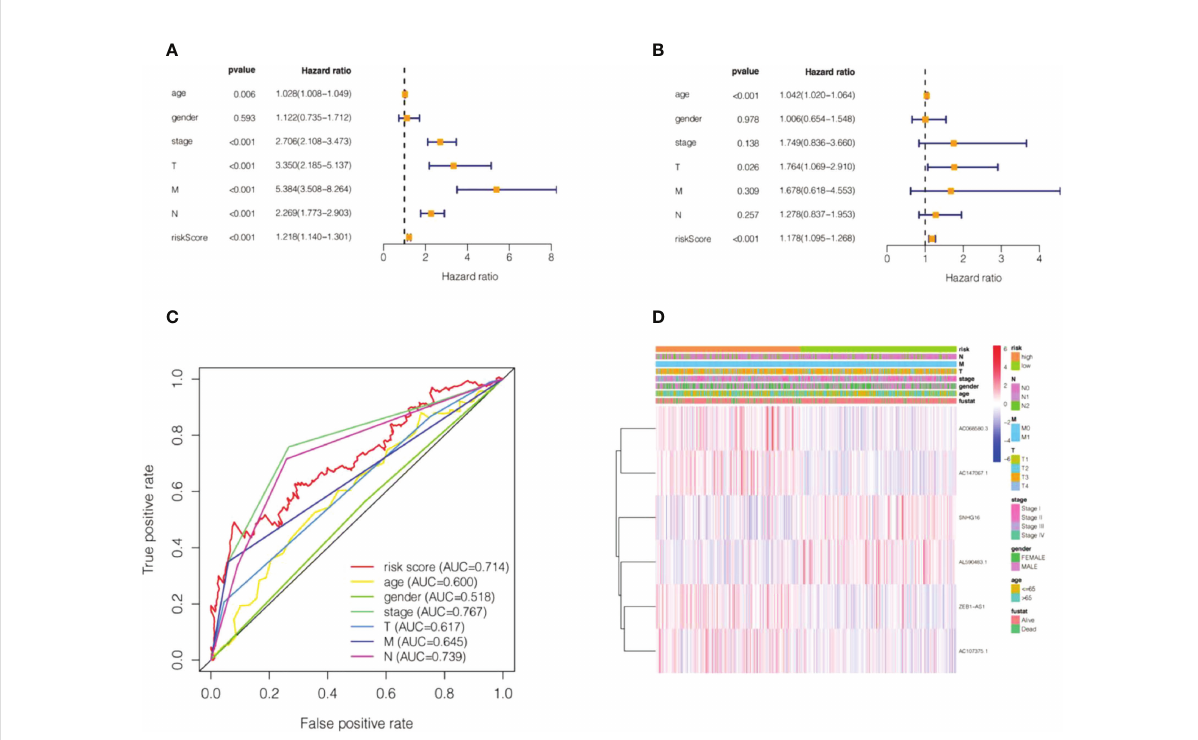
FIGURE 9 Validation of the risk model of cell senescence-related lncRNAs in colorectal cancer. (A) Univariate Cox regression of the risk score and clinical indicators. (B) Multivariate Cox regression of the risk score and clinical indicators. (C) The AUC value for the risk score and clinical indicators. (D) A heatmap of correlations between the risk score and clinical